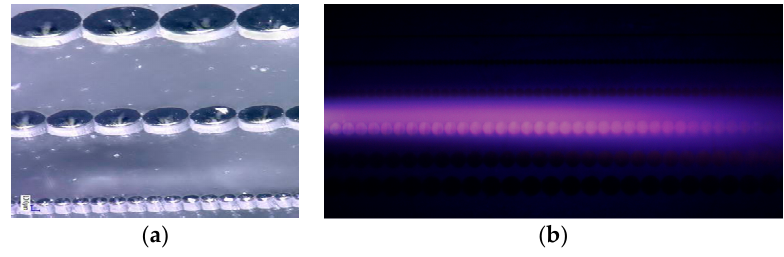
Figure 19. ( a ) SEM of quartz dielectric coupled resonators where the terahertz wave is guided; and ( b ) optical image of the quartz resonators under a helium plasma [40]. The scale bar is 100 μ m.